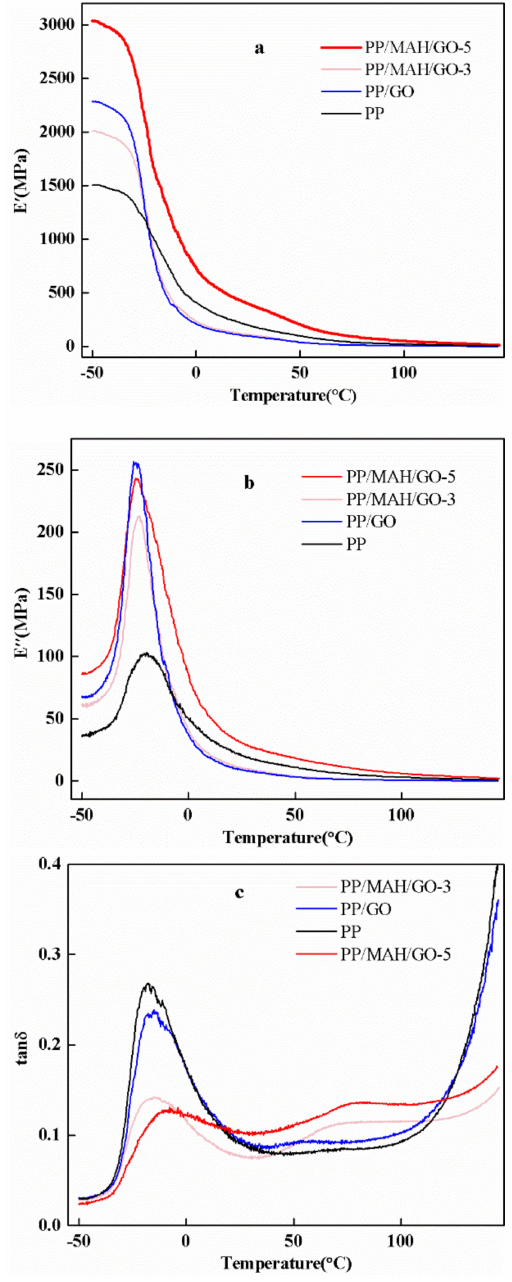
Figure 4. DMA image of pure PP and composite fibers: ( a ) E (cid:48) ; ( b ) E ”; ( c ) tan δ